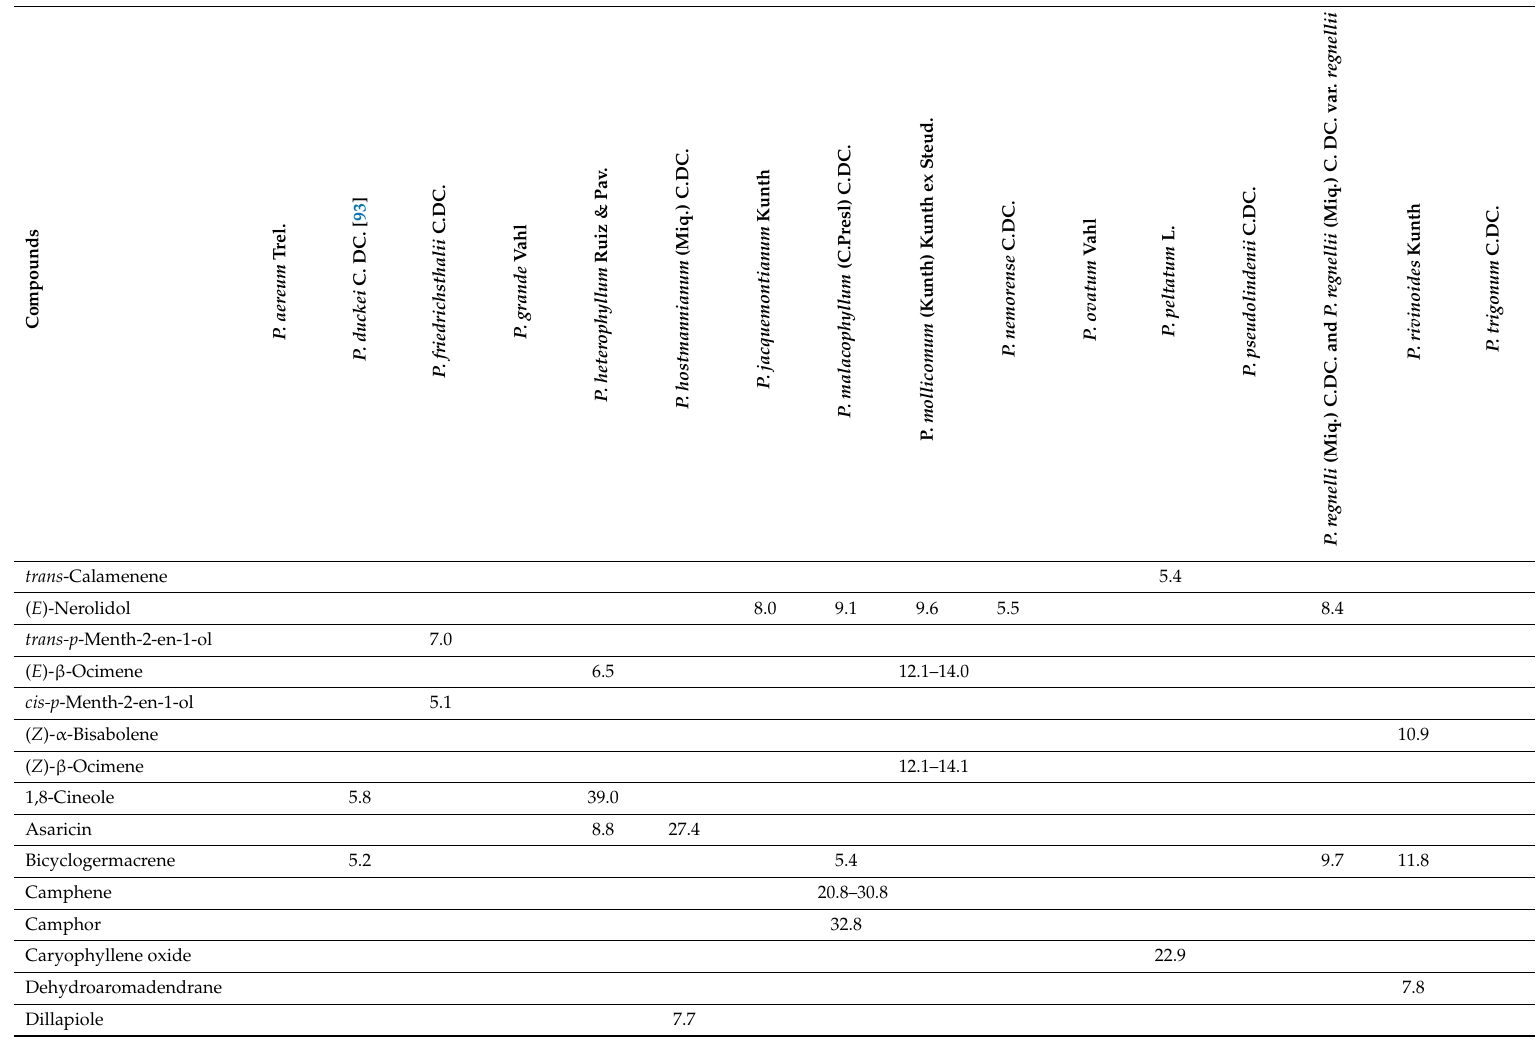
Table 25. Chemical compositions (%) of leaf essential oils from miscellaneous Piper species, part